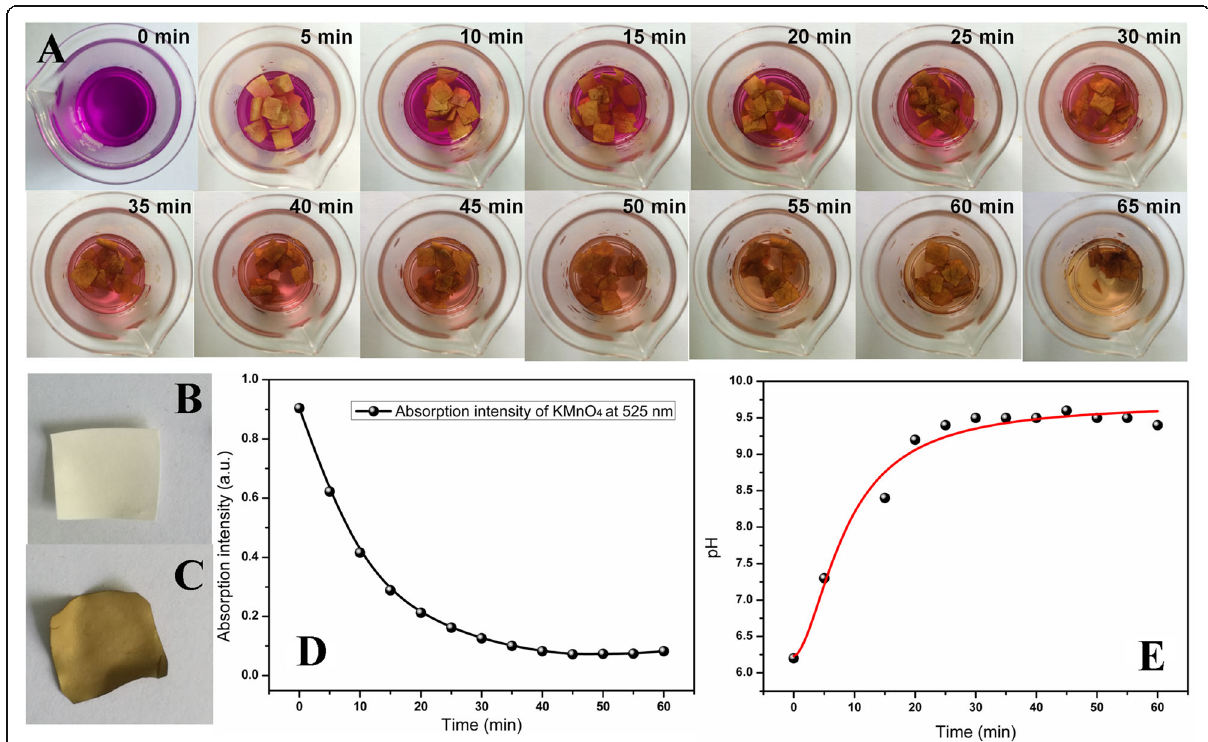
Fig. 1 a The photos of the synthetic system at different times. b The image of ESM slice before the redox reaction. c The image of MnO 2 NPs/ ESM. d The absorption intensity of KMnO 4 at 525 nm. e pH of the synthetic system at different